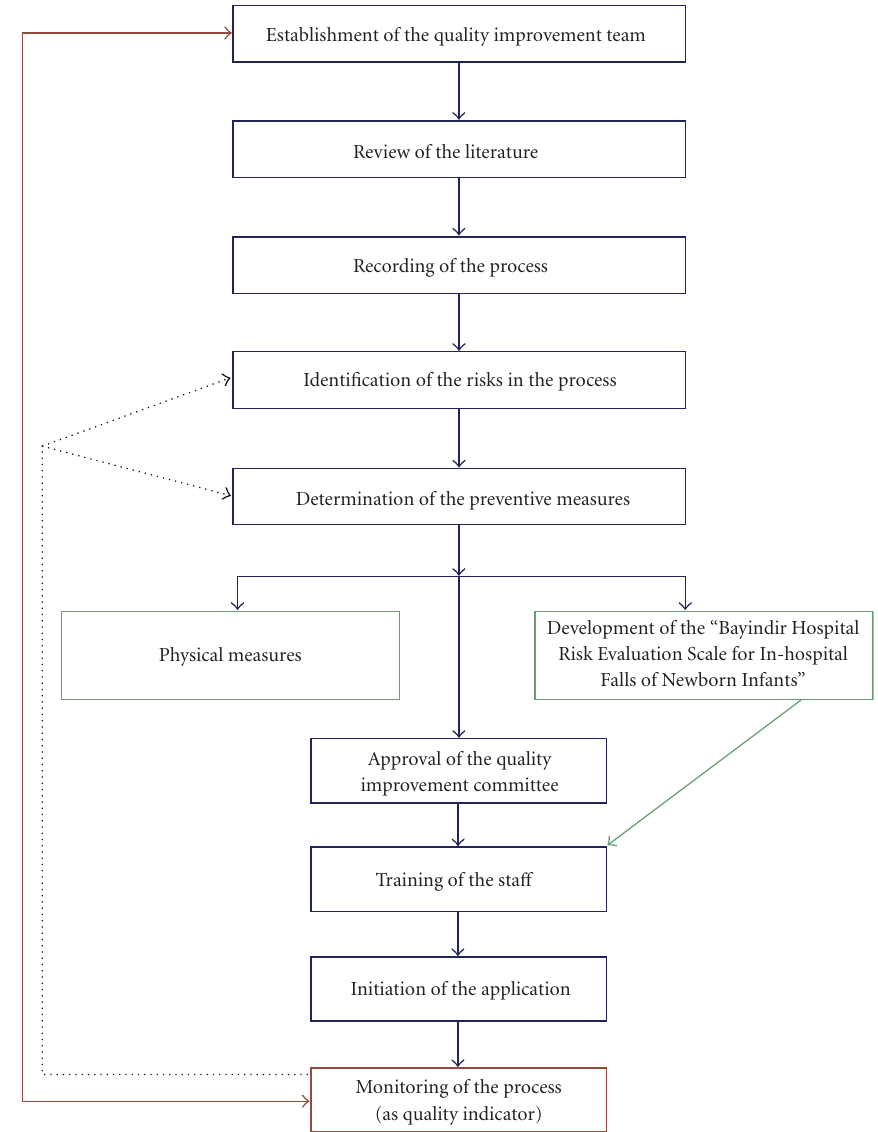
Figure 2: Failure modes and e ff ects analysis workflow